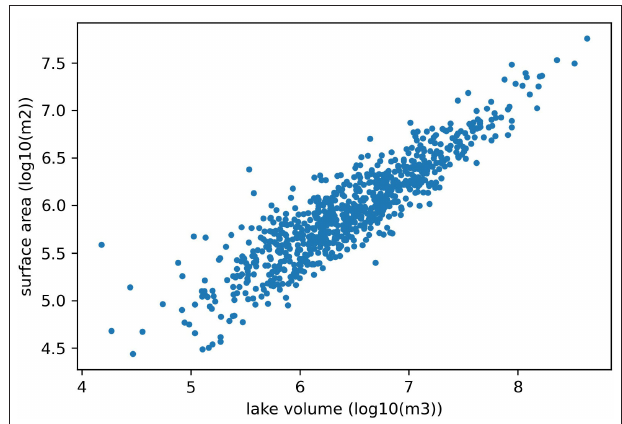
FIGURE 8 | The relationship between lake volume (log scale) and lake surface area (log